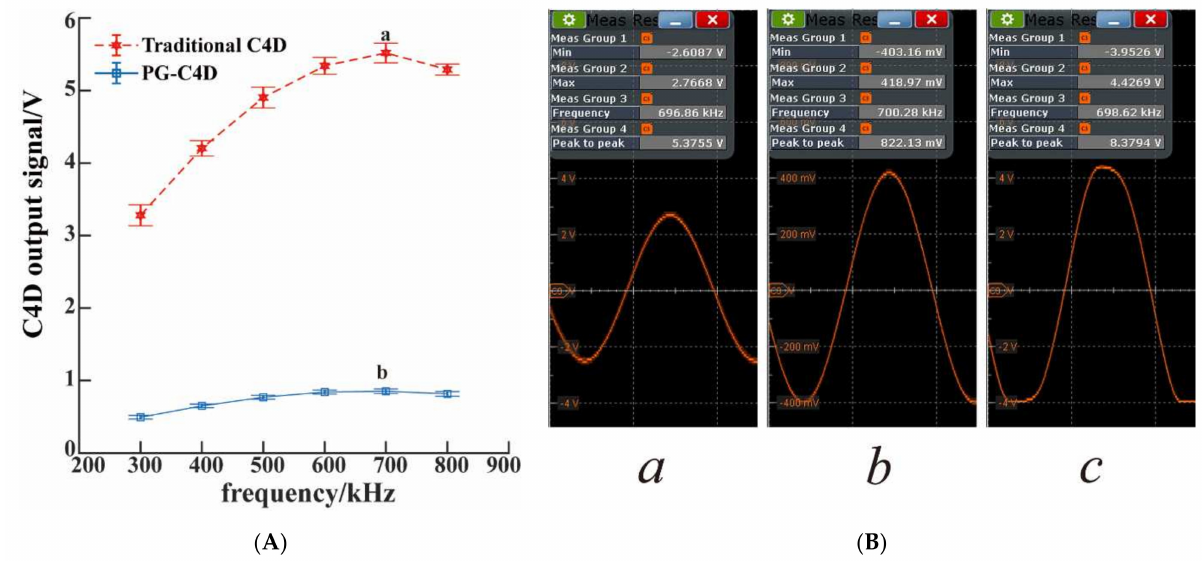
Figure 3. ( A ) C4D output signal. Red dashed line stands for the traditional C4D, and the blue continuous line stands for the PG-C4D. The error bars are the standard deviation of the measurements ( n = 3). ( B ) Maximum output strength of the transimpedance amplifier. a: traditional C4D. b: PG-C4D. c: the excitation amplitude exceeded 10V in traditional C4D (distorted). Experimental conditions: channel filled with running buffer, oscilloscope filter cutoff frequency, 5